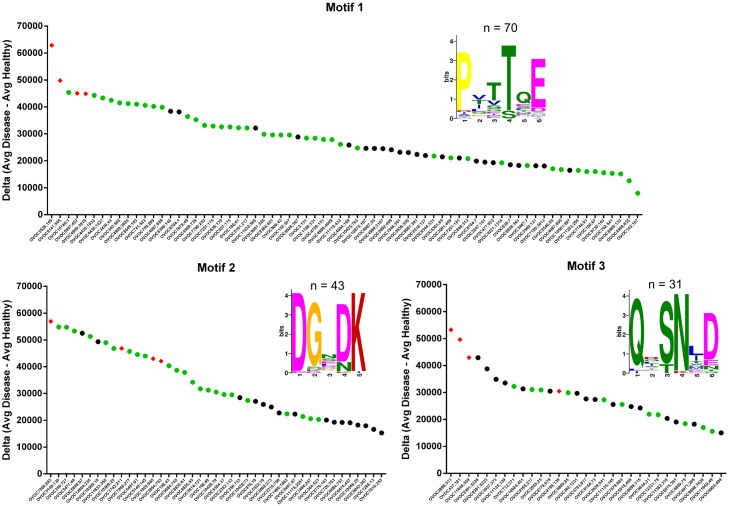
Three immunodominant motifs.For each of the 3 motifs identified, all immunodominant peptides containing one of the motifs (as reported by MEME) are indicated with their corresponding delta value (Avg. Disease–Avg. Healthy Control). Peptides that have been evaluated in peptide ELISA are indicated in green. Peptides that have been further characterized in this study are indicated by red diamonds.